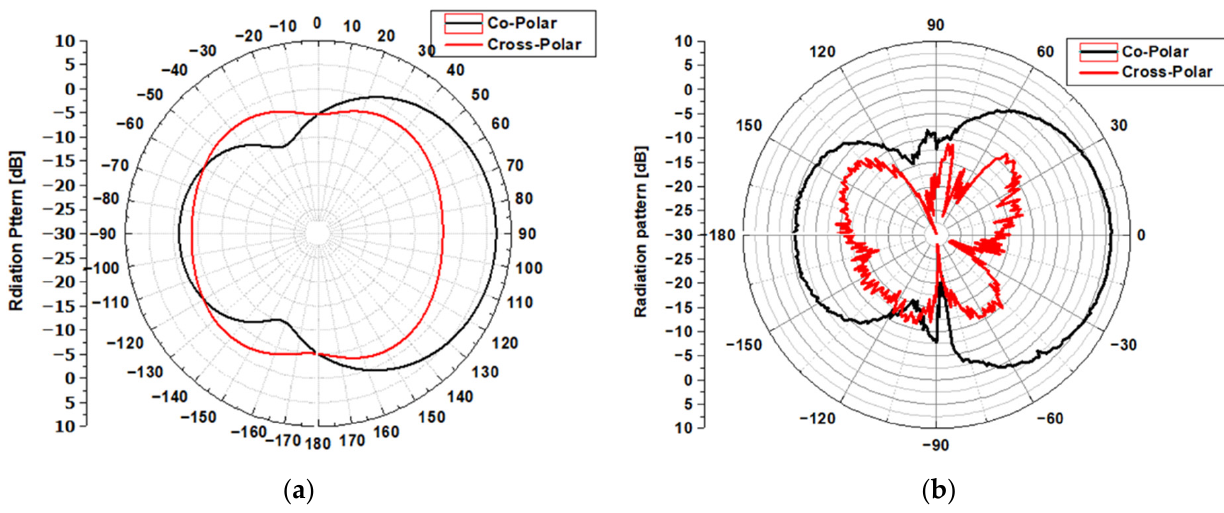
Figure 13. Measurement of the gain in the anechoic chamber.